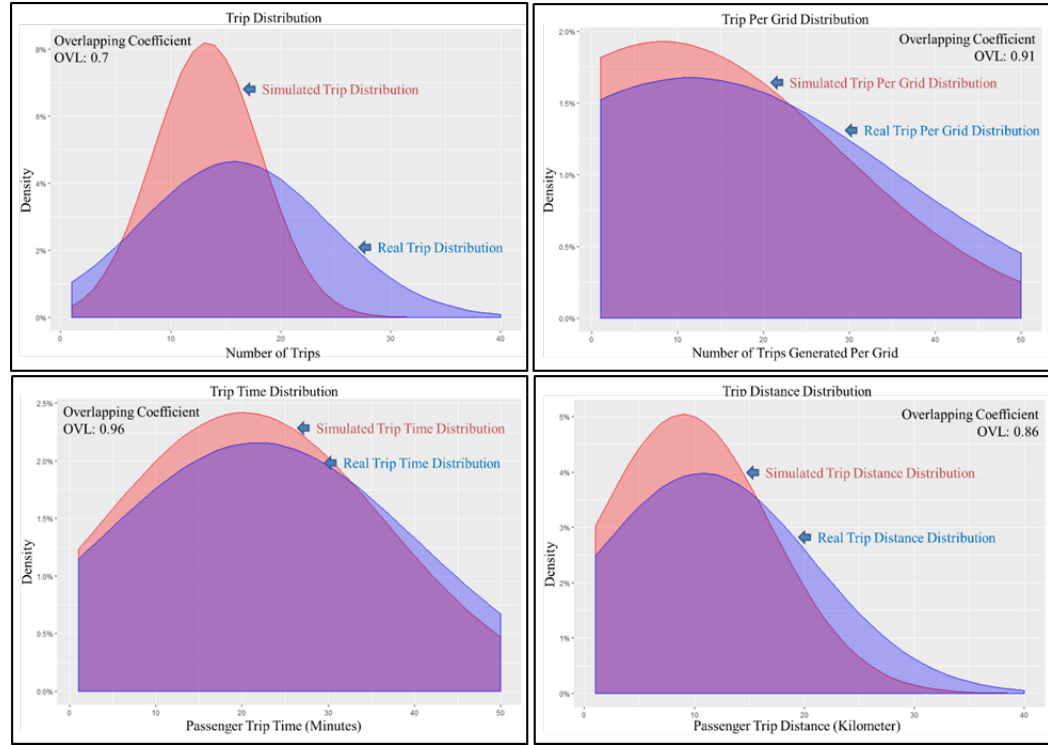
Figure 18. Simulated trip vs Real trip regarding distribution (Day type = Weekend). Table 4. Weekend Simulated Trip Data vs. Real Trip Data comparison.